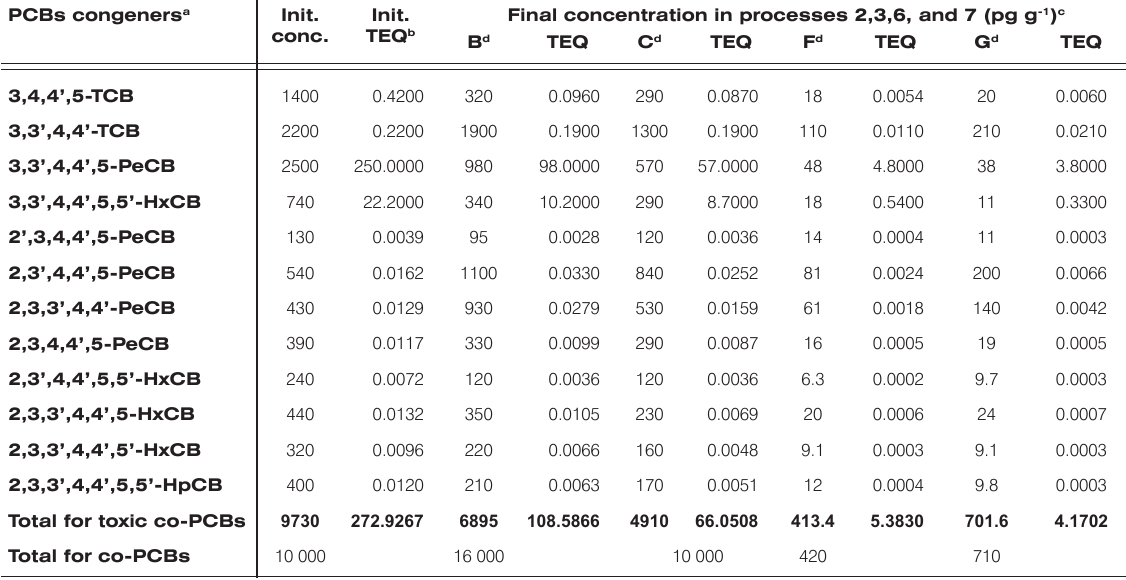
Table 4. Concentrations and TEQs of PCBs congeners, prior to and after treatment. PCBs congeners a Init. conc.